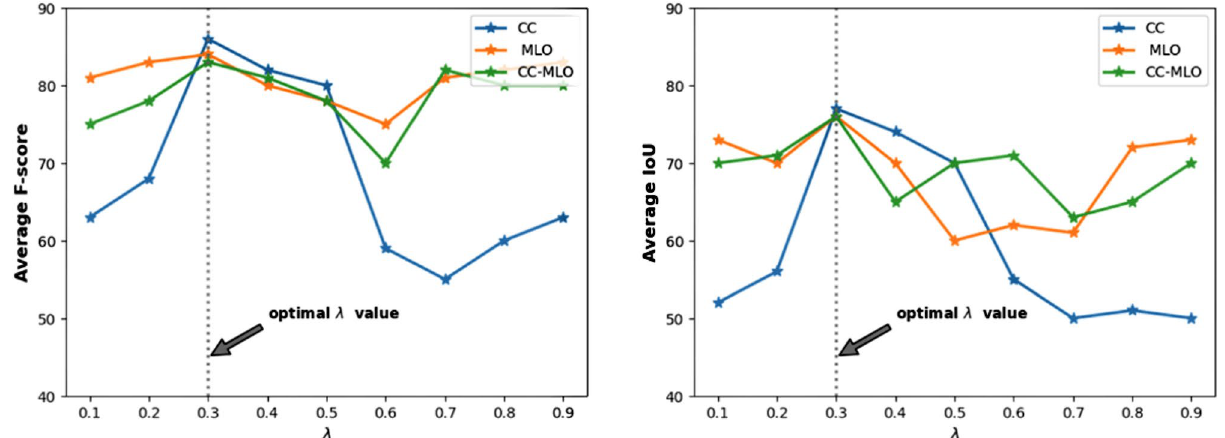
Figure 5. The performance of the naïve multitask loss function on the combined validation set. The weight parameter (cid:31) in the range 0.1–0.9 is on the x-axis, and the segmentation evaluation metrics, IoU and F-score, are on the y-axis. The segmentation model trained with (cid:31) = 0.3 shows better performance compared to the other (cid:31) values.